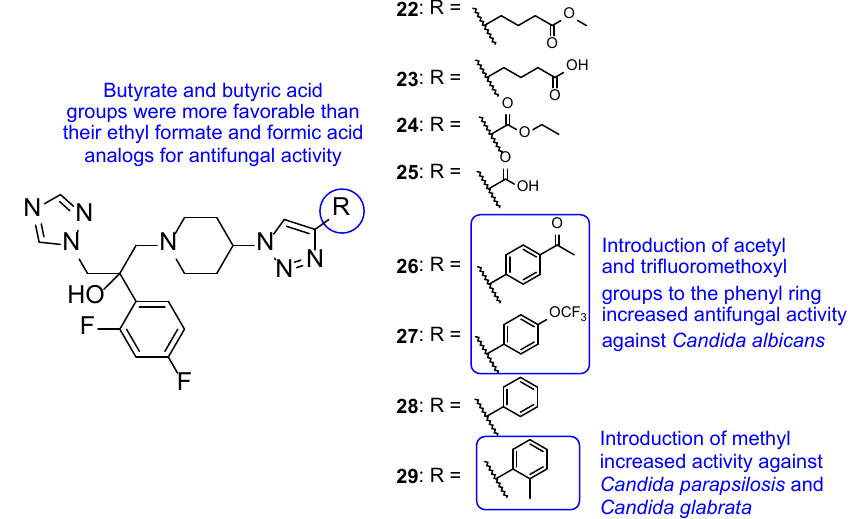
Figure 18. Chemical structures for compounds 22 – 29 , and respective SAR [98]. To enhance some properties of fluconazole, Mahmoudi et al. designed fluconazole derived triazole alcohols, with a N -(halobenzyl)piperazine carbothioate side chain. The new compounds were tested for their antifungal activity against C. albicans , C. glabrata , C. parapsilosis , C. krusei , and C. tropicalis using the broth microdilution method. All tested compounds presented great results against all tested strains, with MIC values comparable or better than those of fluconazole. Compound 30 (Figure 19) displayed excellent results (MIC values ranging from 0.11 to 0.86 µM against all tested fungi) when compared to fluconazole (MIC values ranging from 1.6 to 13.1 µM). Against fluconazole-resistant strains, 30 also showed better results than fluconazole (MIC values from 3.4 to 27.6 µM, while fluconazole was inactive) and compounds 31 and 32 (Figure 19) were also potent against all resistant strains (MIC values ranging from 0.4 to 52 µM). Moreover, the authors concluded that compounds substituted with two fluor substituents at C-2 and C-4 of the phenyl ring were more favorable than their chlorine analogs (Figure 19). Since compound 30 presented excellent results, it was also tested for toxicity against HepG2 cells and erythrocytes, where it displayed minimal toxicity and favorable safety profile, revealing a promising structure for antifungal activity [99].